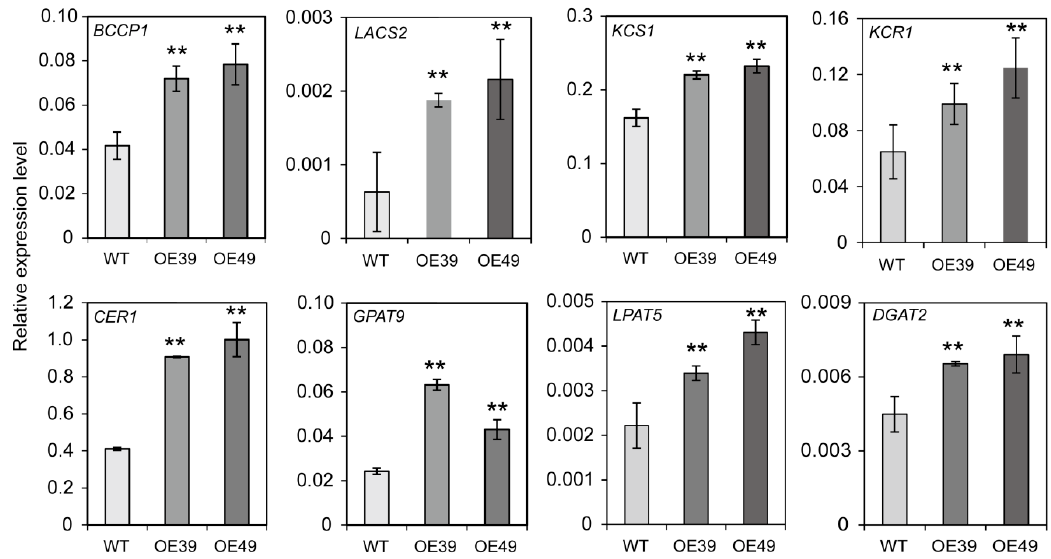
Figure 8. BnWIN1 increased expression of genes related to lipid anabolism. Total RNA was extracted from 40-day-old plants treated with 200 mM NaCl for 12 h. The relative expression levels of genes were analyzed by real-time PCR normalized to β -Actin expression level. Values are means ± SD ( n = 3 separated samples). ** denote significance at p < 0.01 compared with WT plants based on Student’s t test.